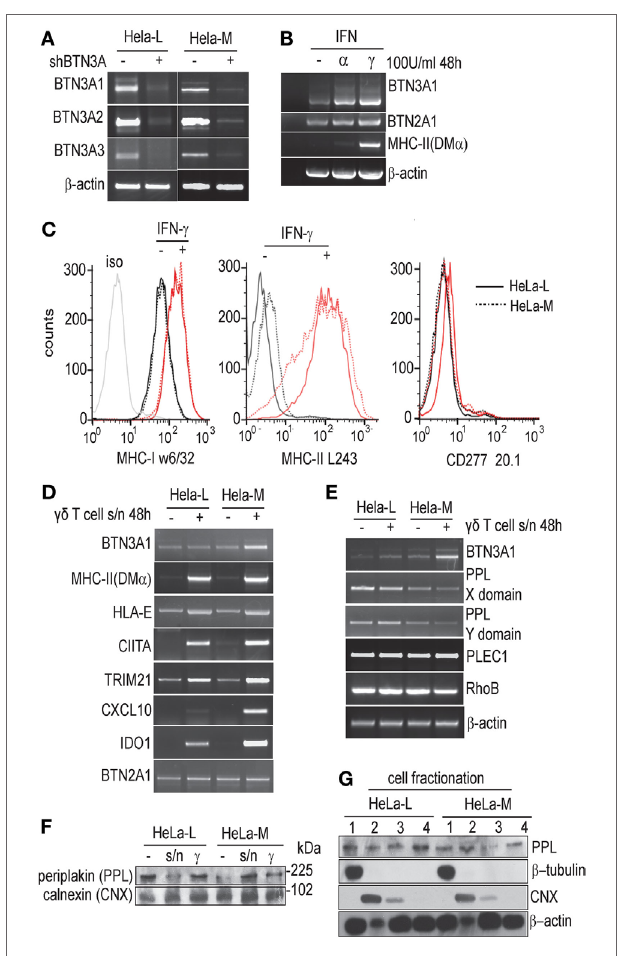
FigUre 2 | Transcripts for the three BTN3A isoforms are unchanged in HeLa-L and HeLa-M. (a) Amplification of full-length BTN3A1, BTN3A2, and BTN3A3 transcripts by RT-PCR from wild-type and shRNA BTN3A HeLa-L and HeLa-M cDNA template. (B) RT-PCR for BTN3A1, BTN2A1, and MHC-II (DM α ) from cDNA derived from HeLa-M cells either left untreated or treated with IFN- α or IFN- γ . RT-PCR products were analyzed by gel electrophoresis, with β -actin as loading control. Results are representative of three experiments. (c) Analysis of activation markers MHC-I (w6/32), MHC-II (L243), and BTN3A (CD277 20.1) by flow cytometry in HeLa cells treated with or without IFN- γ . Results representative of triplicate experiments. Red lines indicate IFN- γ treated and black lines untreated samples. Solid lines are HeLa-M and dotted lines HeLa-L. (D) Expression of activation markers as detected by RT-PCR in HeLa-L and HeLa-M cells left untreated or treated with γδ T/HeLa-M cell coculture supernatant collected as described (see Materials and Methods). Transcripts for BTN3A1, HLA-E, DM α , CIITA, TRIM21, CXCL10, IDO-1, and BTN2A1 were amplified and visualized by gel electrophoresis. Results are representative of duplicate experiments. (e) Expression of the BTN3A1 interacting molecules protein periplakin (PPL) and RhoB in treated and untreated HeLa-L and HeLa-M cells analyzed by RT-PCR, as in (c) , with transcripts for β -actin as a loading control. Results are representative of duplicate experiments. (F) Lysates from HeLa-L and HeLa-M cells left untreated or treated with γδ T/HeLa-M cell coculture supernatant or IFN- γ , were analyzed by western blot for expression of PPL protein. Duplicate blots were probed with calnexin (CNX) antibody as a loading control. (g) Cell fractionation to compare the sub-cellular distribution of PPL protein in HeLa-L and HeLa-M cells. Fractions for soluble (1), membrane (2), nuclear (3), and cytoskeletal/detergent resistant membrane (4) fractions were prepared and analyzed by western blot using anti-PPL, β -tubulin, CNX, and β -actin